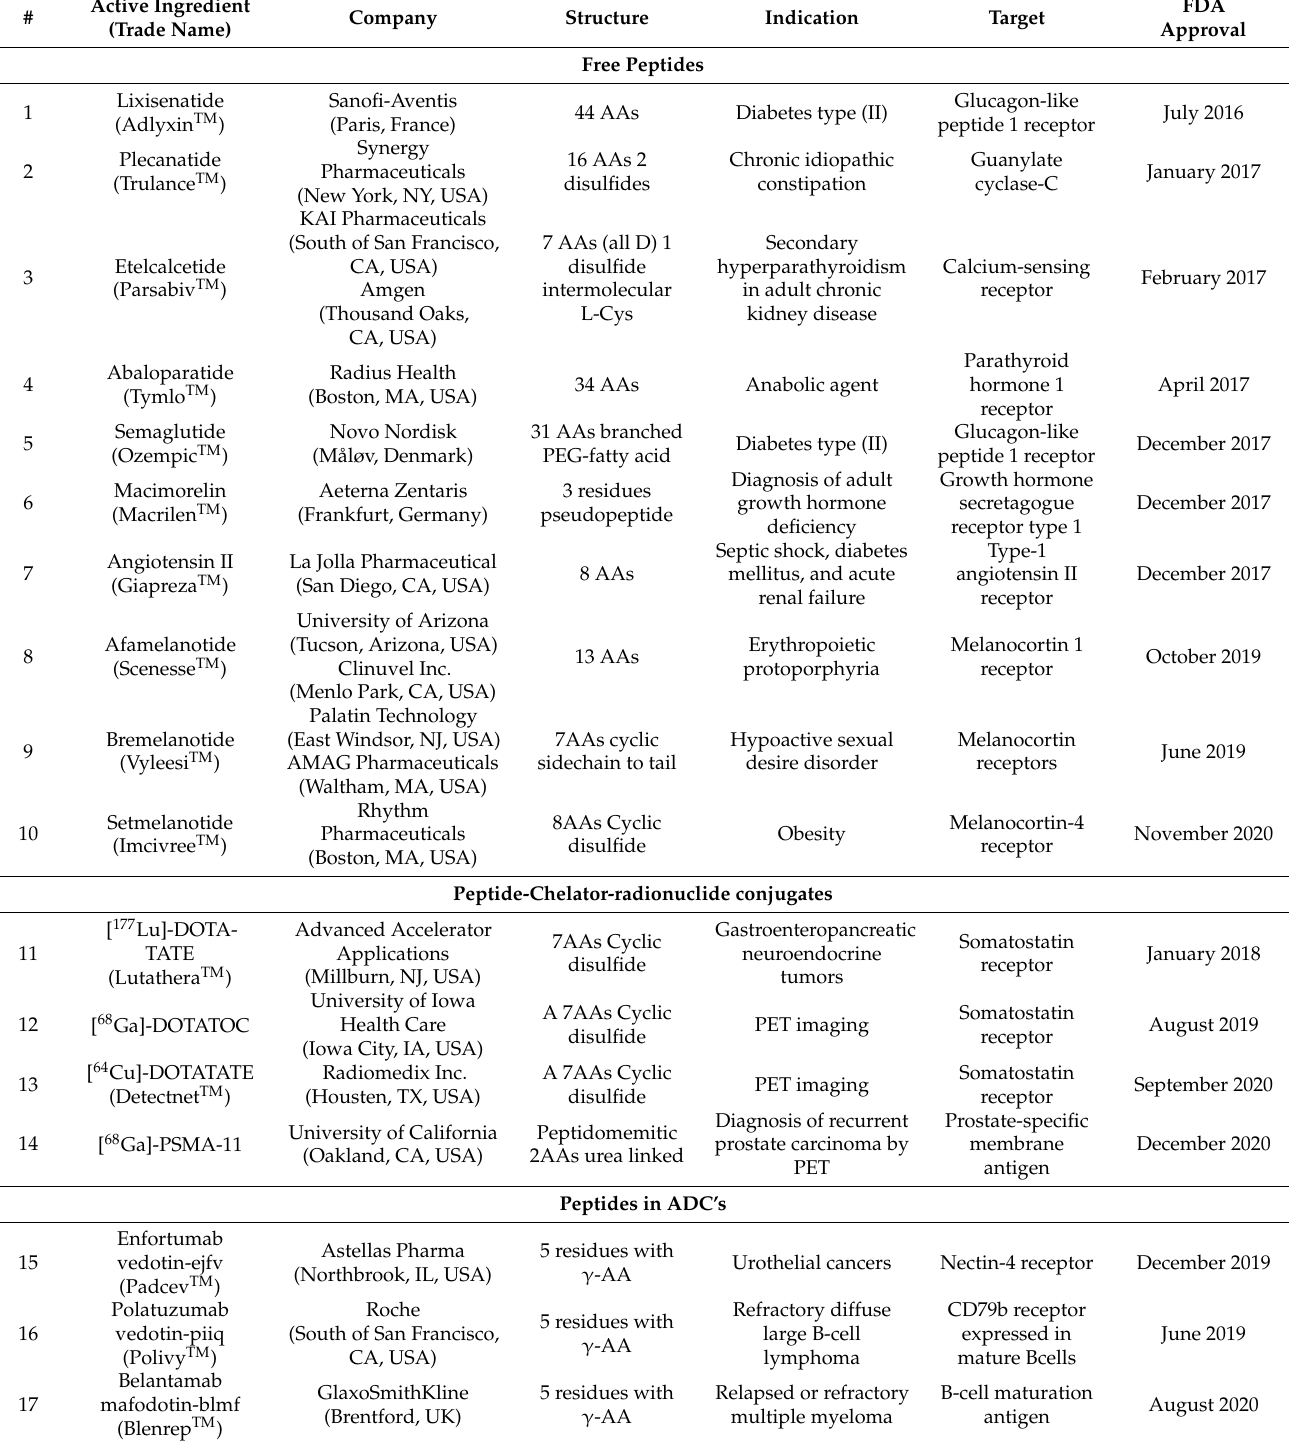
Table 3. FDA-approved peptides between 2016 and